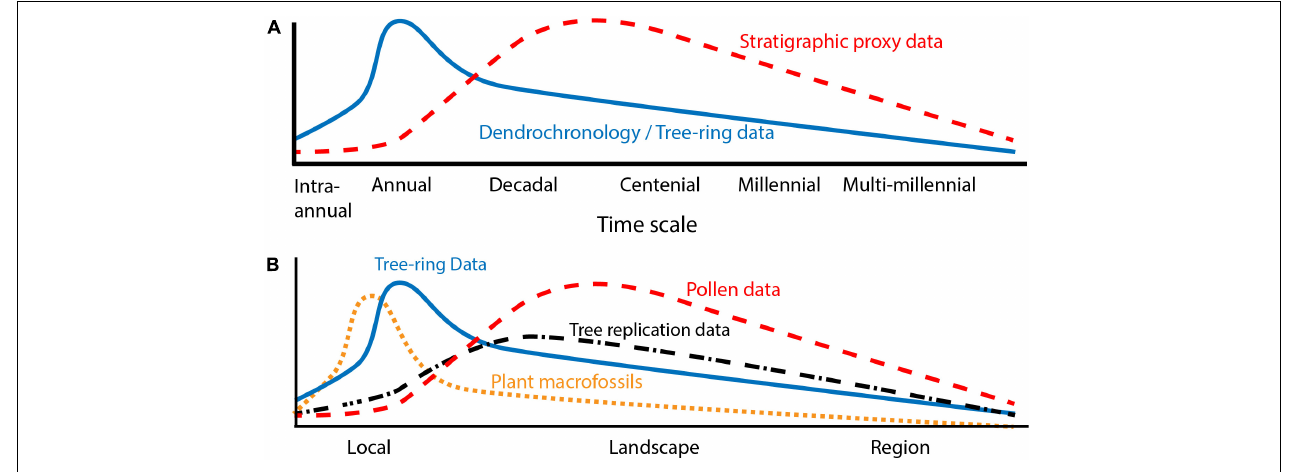
FIGURE 6 | (A) A schematic presentation of temporal scales associated with tree-ring data (blue line) and stratigraphic proxy data (red dashed line). (B) The proxy data discussed, namely tree-ring data (blue line), tree replication data (black line with dashes and dots), pollen data (red dashed line), and plant macrofossils (orange dotted line), also differ in the spatial scales at which they best represent paleoecological and paleoclimatic information. The advantages of integrating several types of proxies are that both time scale and geographical coverage can be improved. TABLE 2 | Pros and cons of different proxy data for the assessment of paleoecological and paleoclimatic reconstructions. Data Pros Cons Pollen Accessible Time consuming Long records Dating uncertainties Dating